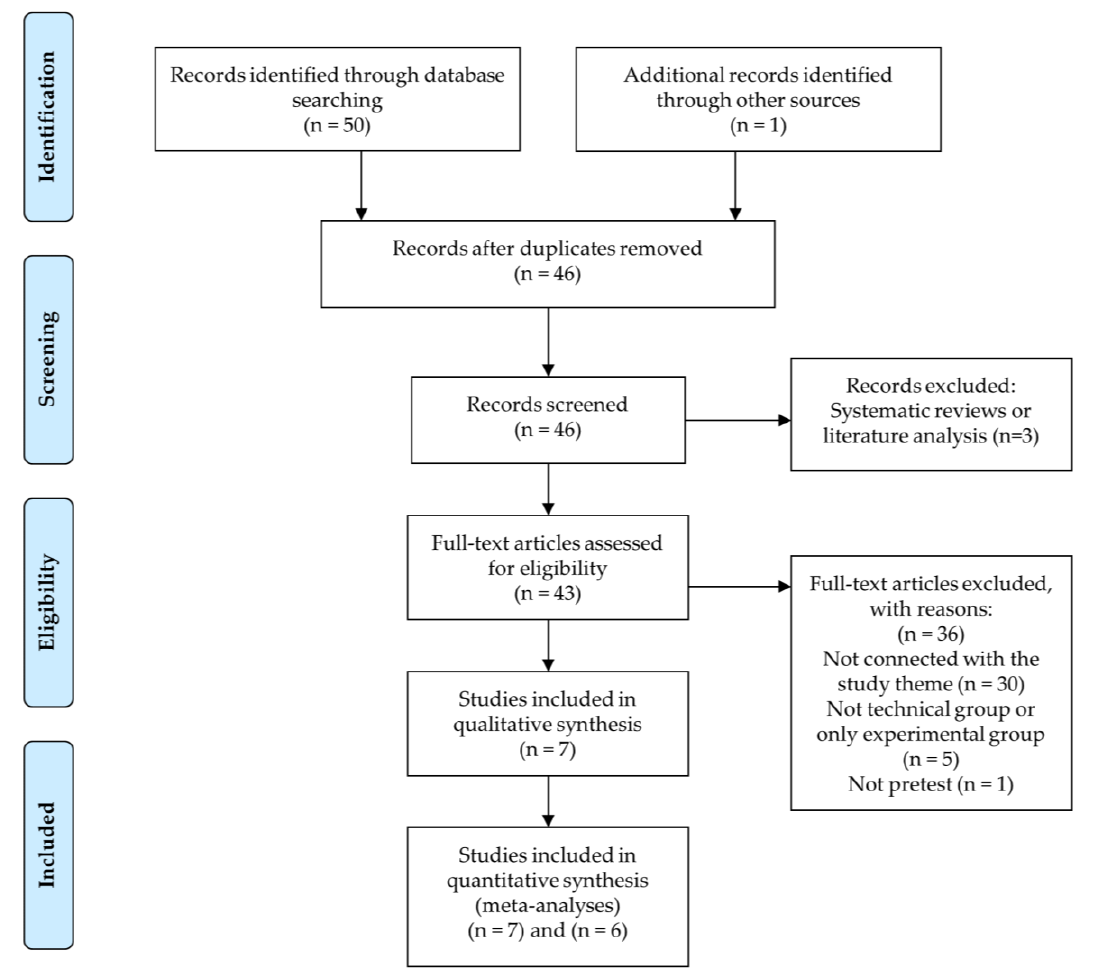
Figure 1. Flow diagram for the systematic review process according to Preferred Reporting Items for Systematic Review and Meta-Analysis Protocols (PRISMA) statements.